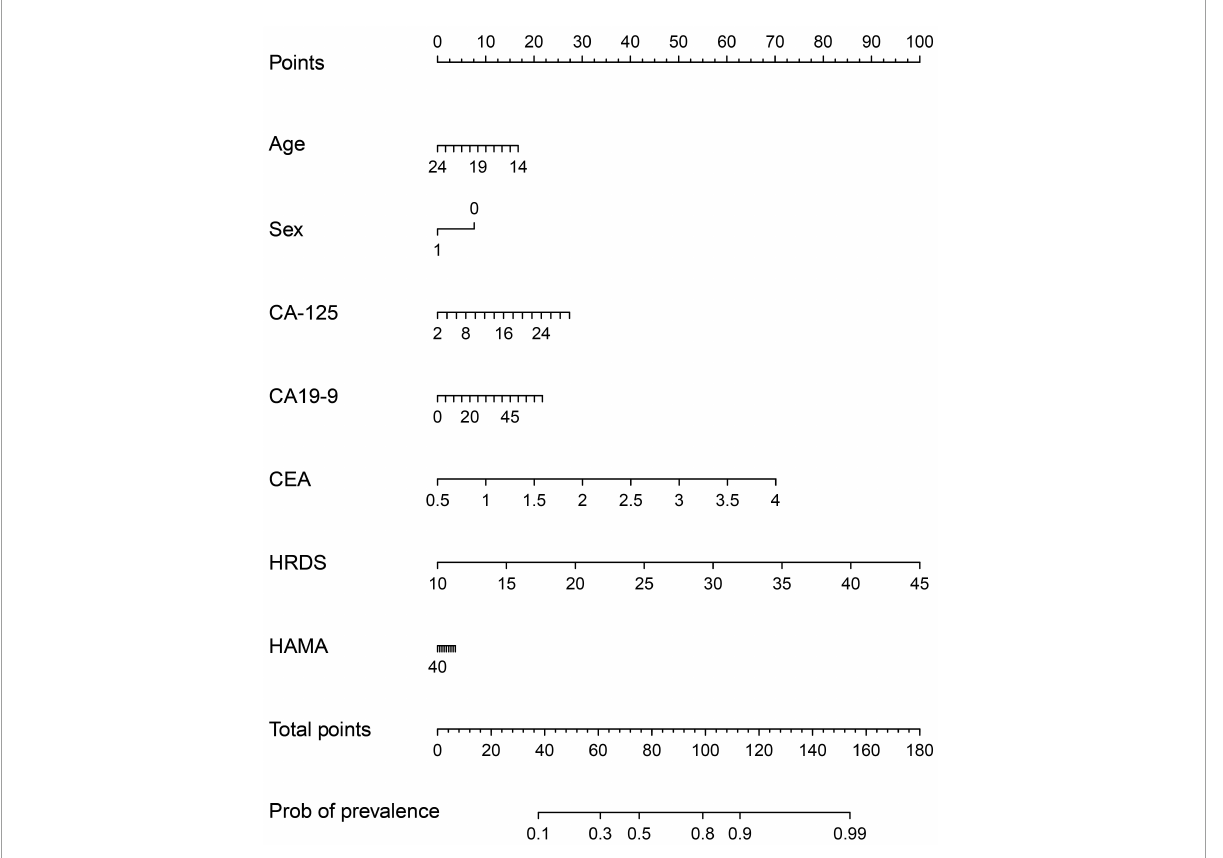
FIGURE5 A nomogram predicting the risk of NSSI for adolescents with depressive disorder. The value of each of variable was given a score on the point scale axis. A total score could be easily calculated by adding each single score and, by projecting the total score to the lower point scale were able to estimate the probability of